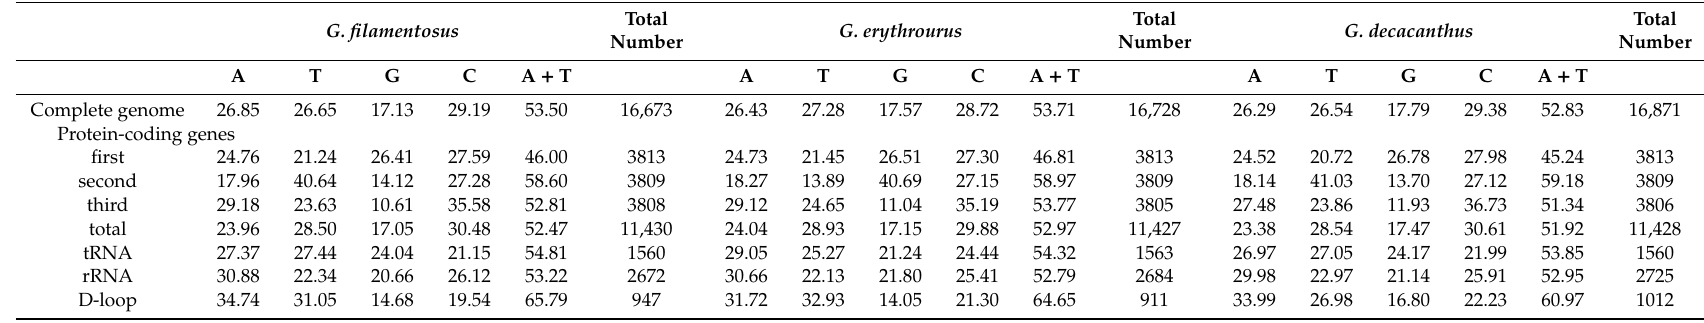
Table 2. Base composition for protein-coding, tRNA, rRNA genes, and D-loop region of the mitogenomes of G. decacanthus , G. erythrourus , and G. filamentosus . G.